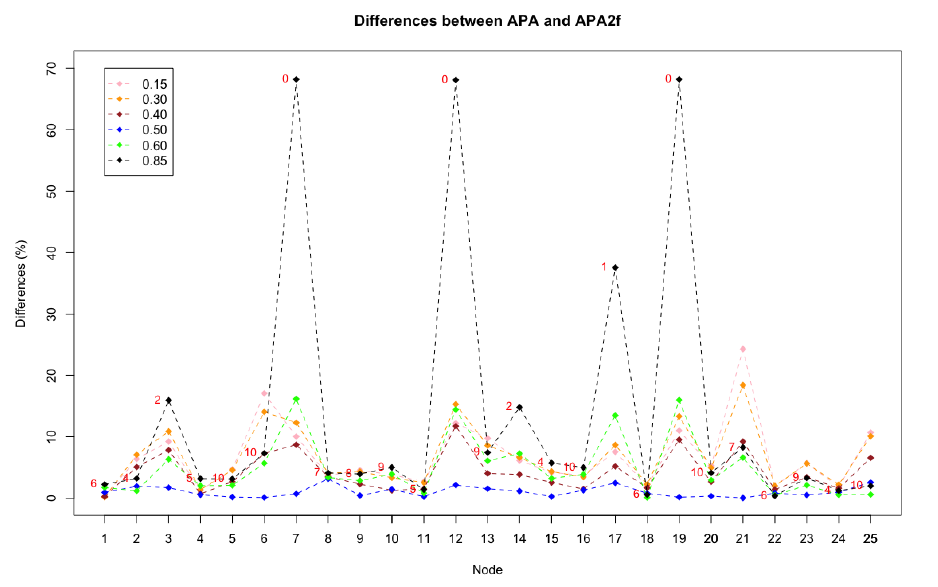
Figure 5. Differences between APA and APA2f centralities for different values of the parameter α